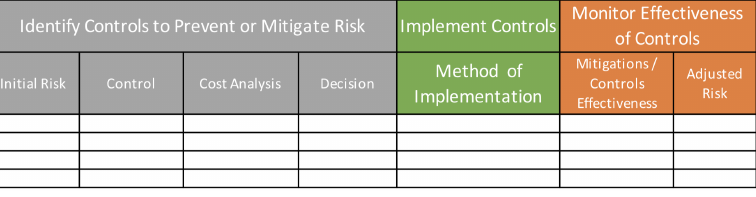
Figure 5. Phase 4 to 6